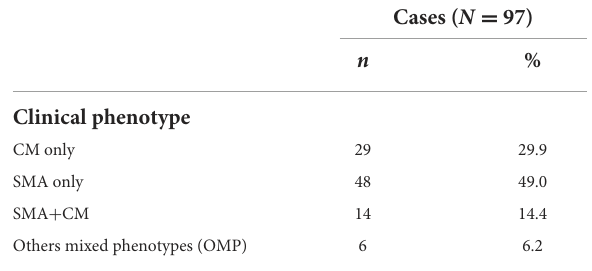
TABLE 2A Distribution of severe malaria clinical phenotypes in the case-control study.